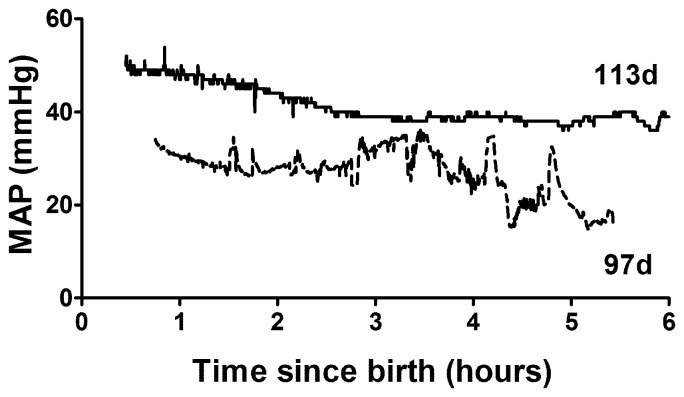
Mean arterial blood pressure (MAP) for a preterm (97d) and a term (113d) piglet (term = 115d) for six hours following delivery by Caesarean section.Note the preterm piglet has a lower and less stable mean arterial pressure (MAP).